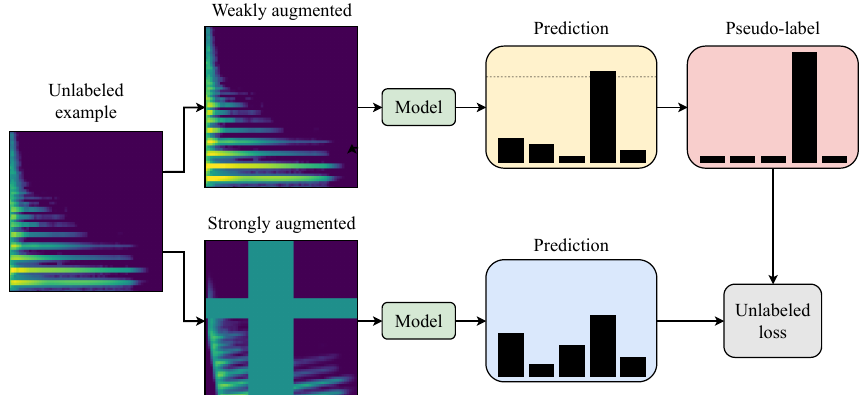
Figure 1. Schematic representation of FM training process for the unlabeled part of the dataset. The model generates a hard label on weakly augmented versions of an unlabeled example. The model is then trained to output the same label for a strongly augmented version of the example. Figure modified from